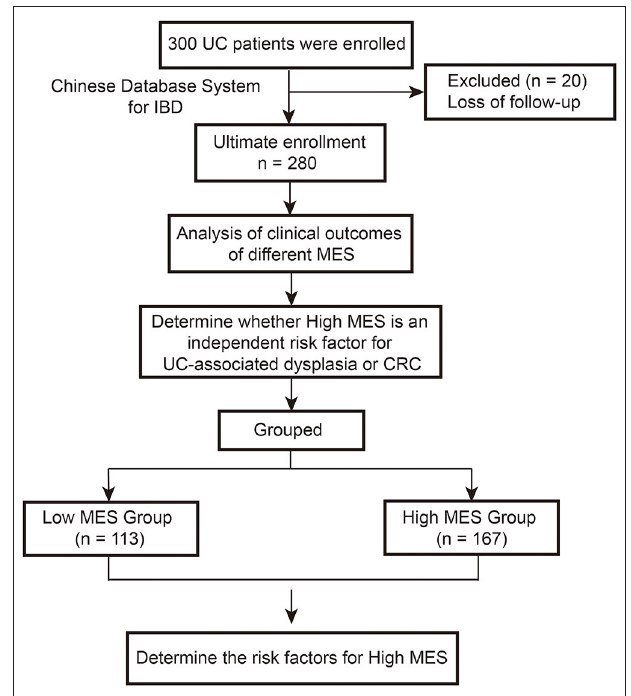
FIGURE 1 | Flow chart of the study